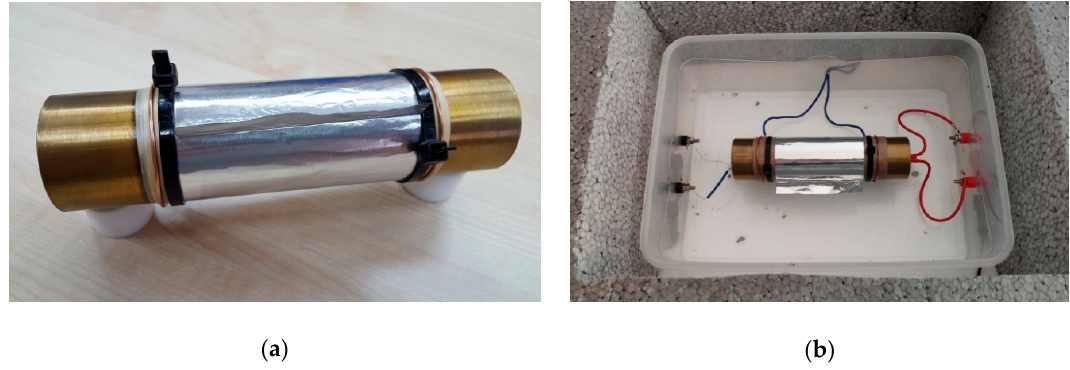
Figure 4. Photograph of the insulation sample prepared for testing: ( a ) zoom on sample; ( b ) after placing the sample in the measuring system.